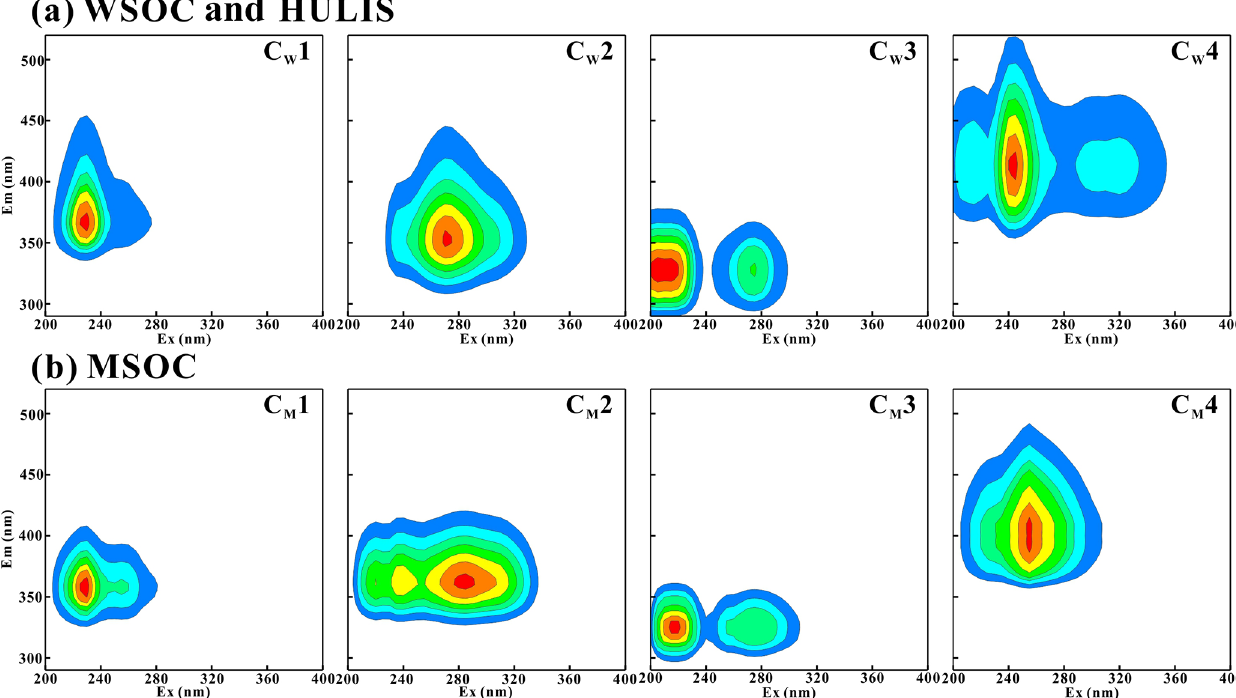
Figure 3. Four fluorescence components identified by PARAFAC analysis of (a) WSOC and HULIS (C W 1 : C W 4) and (b) MSOC (C M 1 : C M 4) extracted from BB and CC smoke PM 2 . 5 (normalized in Raman unit,